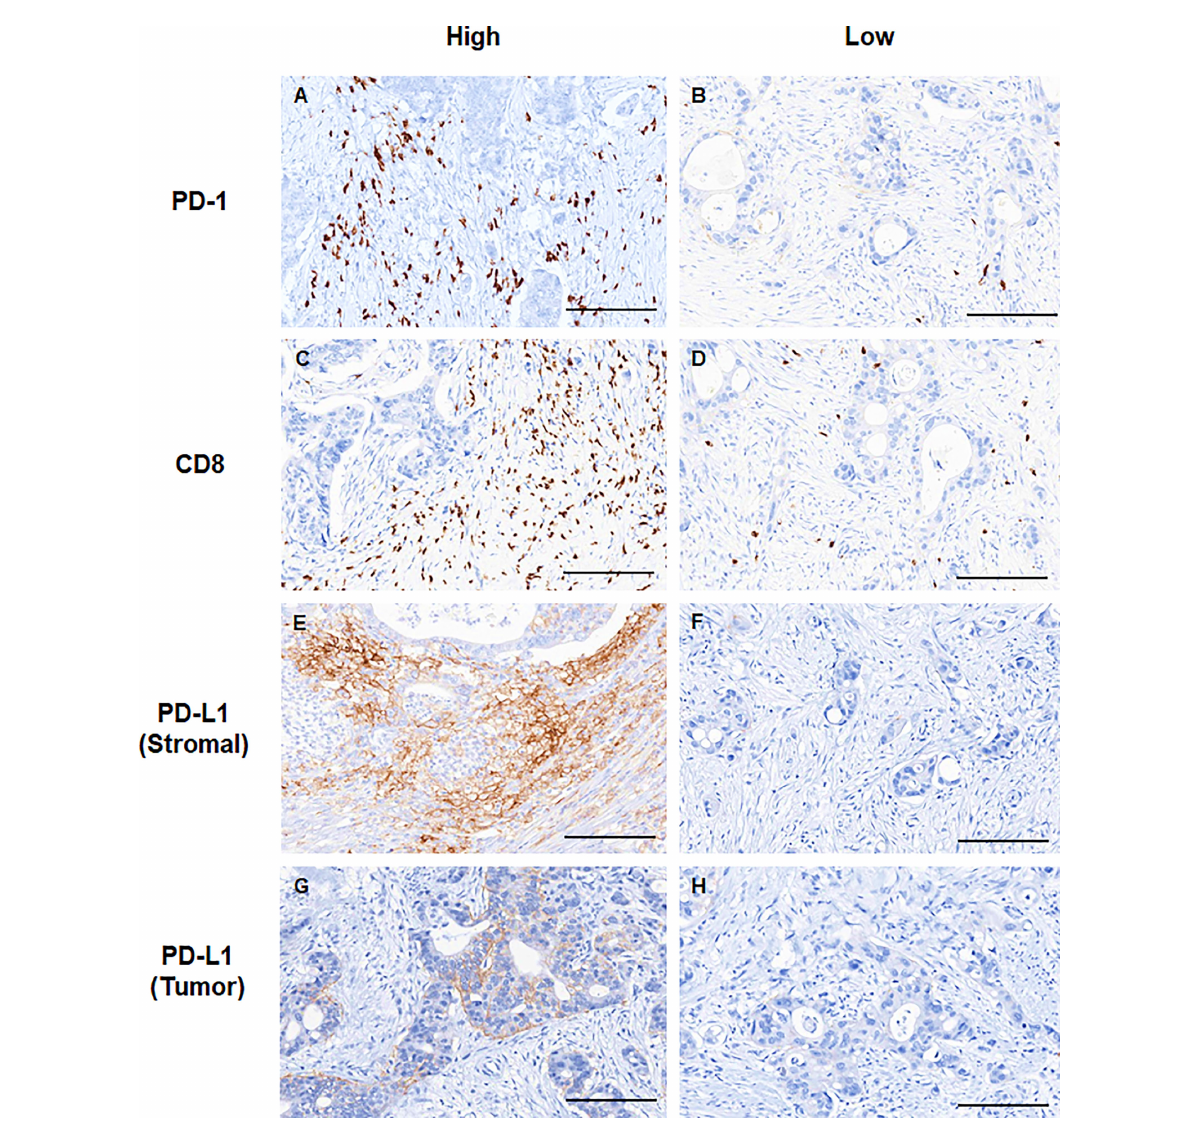
FIGURE 2 Representative immunohistochemical images showing high ( left column ) and low ( right column ) expression levels of (A, B) PD-1, (C, D) CD8, (E, F) stromal PD-L1, and (G, H) tumor PD-L1. Scale bar: 100 m m. PD-1, programmed cell death-1; PD-L1, programmed death-ligand